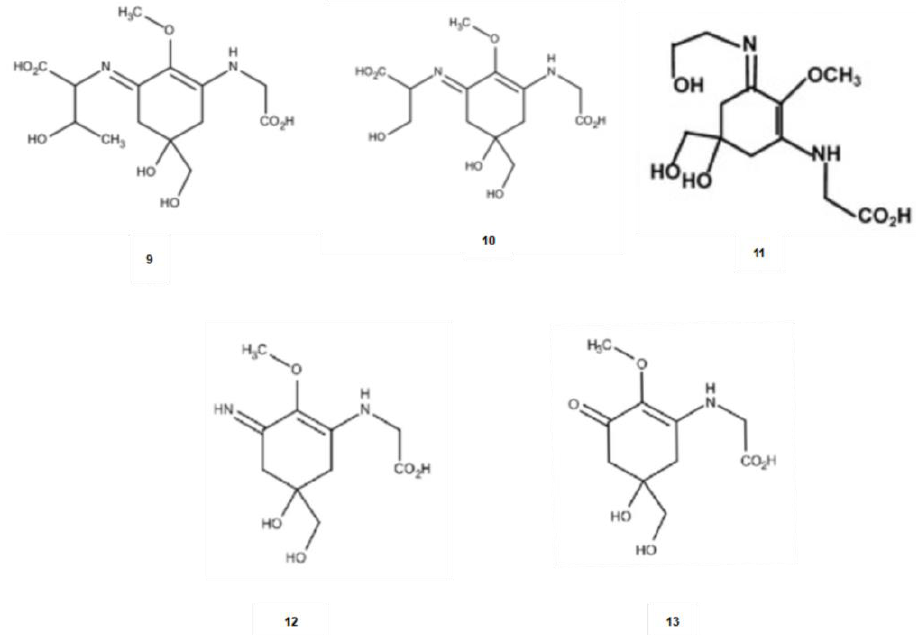
Figure 3. Mycosporine-like Amino Acids from macroalgae.